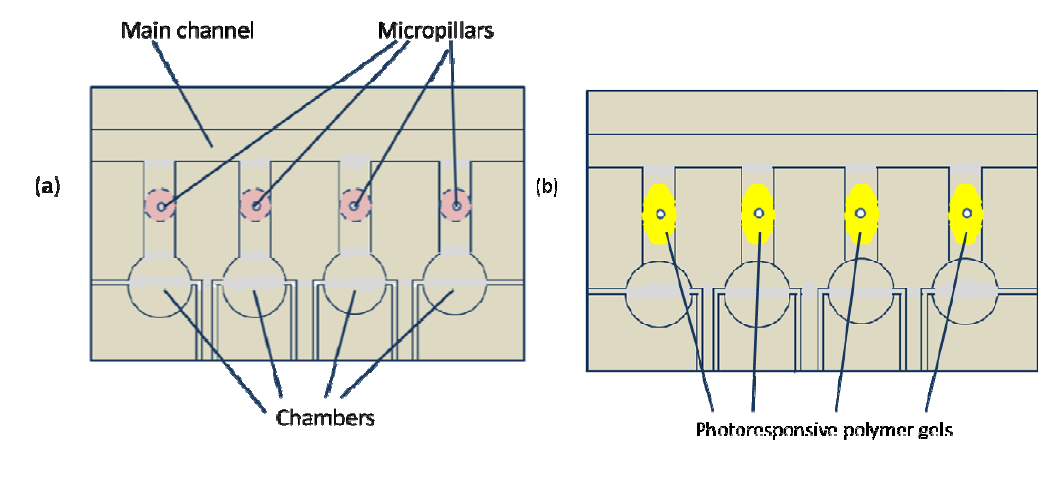
Figure 27. Light-controlled